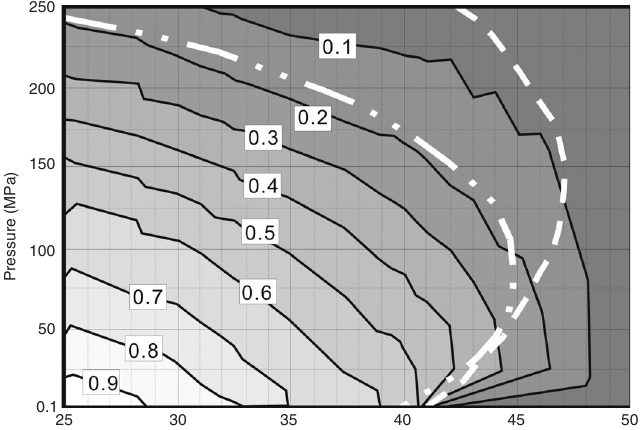
Figure 5. The relative volumes of the poly(N-vinyliso- butyramide) (pNVIBA) gel at various temperatures and pressures, presented in the form of a contour map. The reference volume is that at 25 º C and 0.1 MPa. For comparison, the transition curves of the soluble pNVIBA are overlaid: Mw = 11 kDa (dashed line) and = 66 kDa (dotted line; data from Ref.